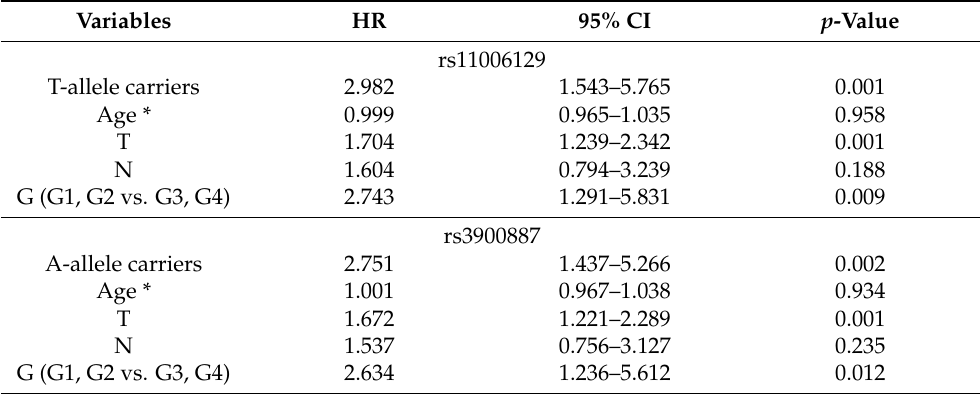
Figure 1. Overall survival of patients with different TFAM and POLG genotypes. Kaplan–Meier survival curves for overall survival of ( a ) TFAM rs11006129 T-allele carriers ( p = 0.003); ( b ) patients with TFAM rs11006129 CC and CT genotypes ( p = 0.003); ( c ) TFAM rs3900887 A-allele carriers ( p = 0.011); ( d ) patients with TFAM rs3900887 AT and TT genotypes ( p = 0.004) and TT and AT genotypes ( p = 0.001). Censored cases are shown as a vertical line. The shadow with the same color represents the 95% confidence interval. Table 7. Cox multivariate model with additional cofactors for patients’ overall